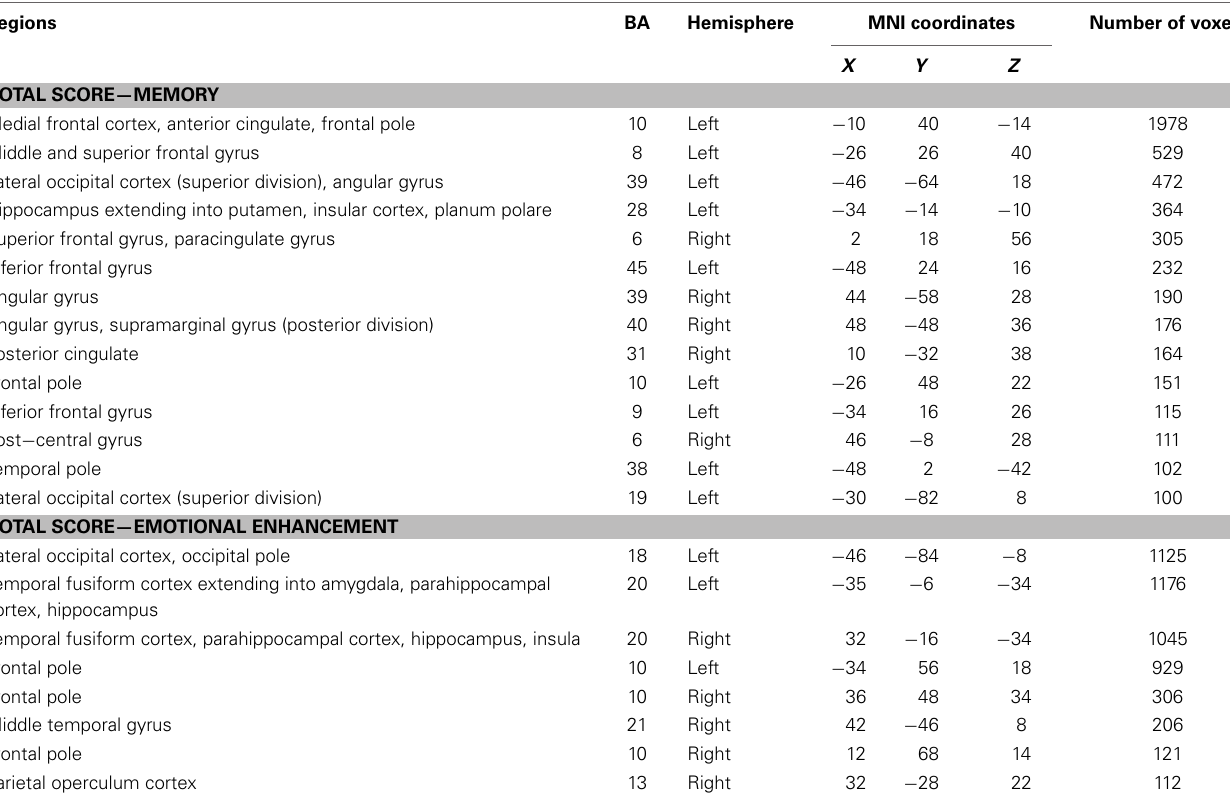
Table 4 | Voxel-based morphometry results showing regions of gray matter intensity that covary with memory performance and emotional enhancement of memory in all participants combined at p < 0.005, uncorrected for multiple comparisons. Regions